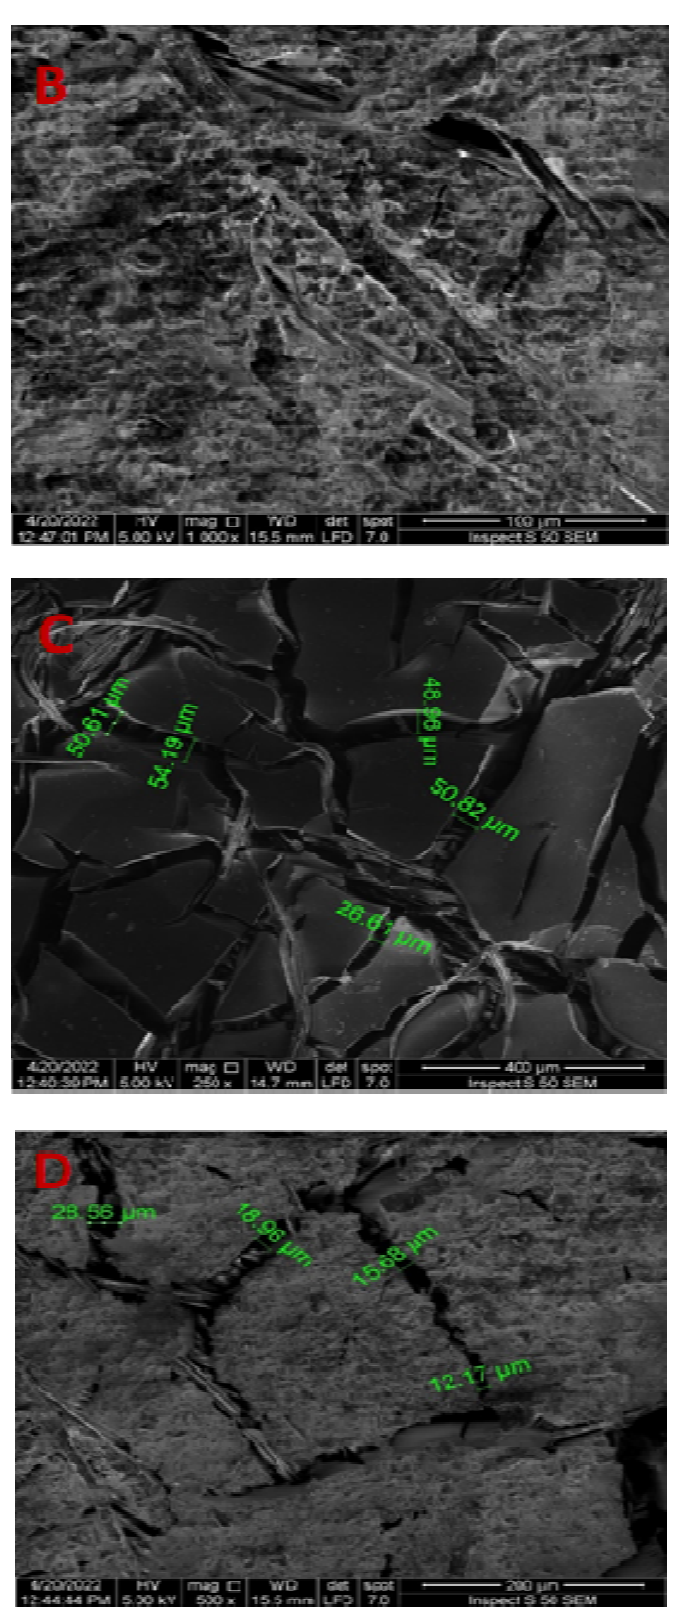
Fig. 7. The SEM & the pore size for the Anion Exchange Membrane before and after